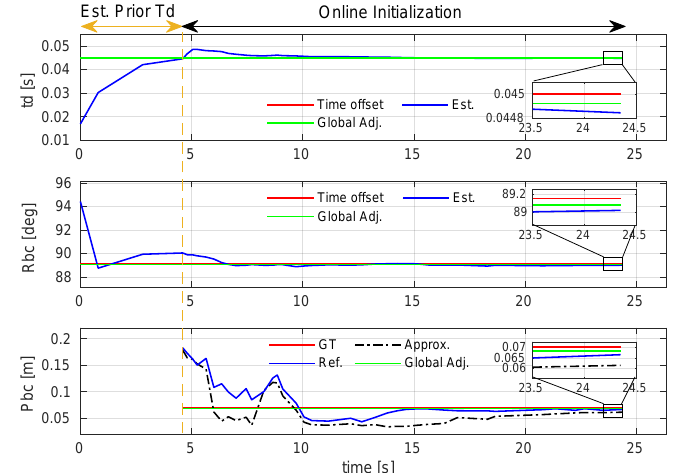
Figure 9. Comparison of the calibrated spatial and temporal parameters using the V2_01 sequence. The section labeled by “Est. Prior Td” denotes a stage where we update the time offset and relaunch the system. Abbreviations: Est.—Estimated; Global Adj.—Global adjustment; GT—Ground-truth;